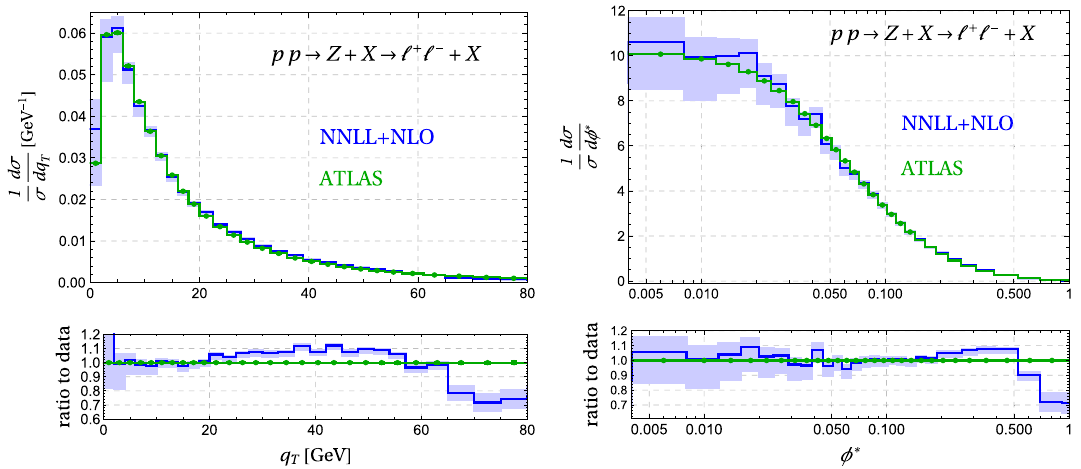
Fig. 10 Comparison of the matched NNLL result to ATLAS data. The experimental uncertainties (green dots) are below 1% and thus invisibly small, the theoretical ones (blue bands) are obtained from scale variation, see